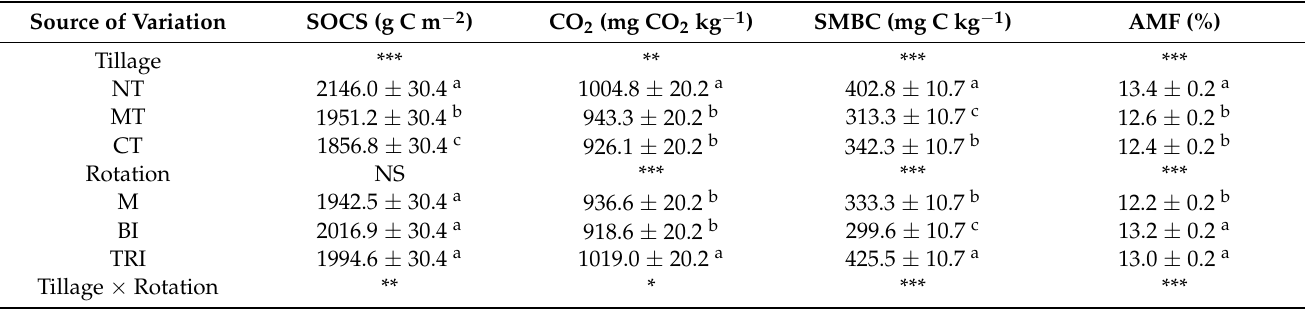
Table 1. Significance from ANOVA testing Tillage effect (No-till: NT, Moderate tillage: MT, and Conventional tillage: CT) and Rotation effect (Monocropping: M, biennial: BI, and triennial: TRI) and their interaction (Tillage × Rotation) effect on soil organic carbon stock (SOCS), soil microbial respiration (CO 2 ), soil microbial biomass carbon (SMBC), and arbuscular mycorrhizal fungal (AMF) root colonization. Data are averages ± standard errors. Different lowercase letters indicate significant differences between all treatments in each item ( p <